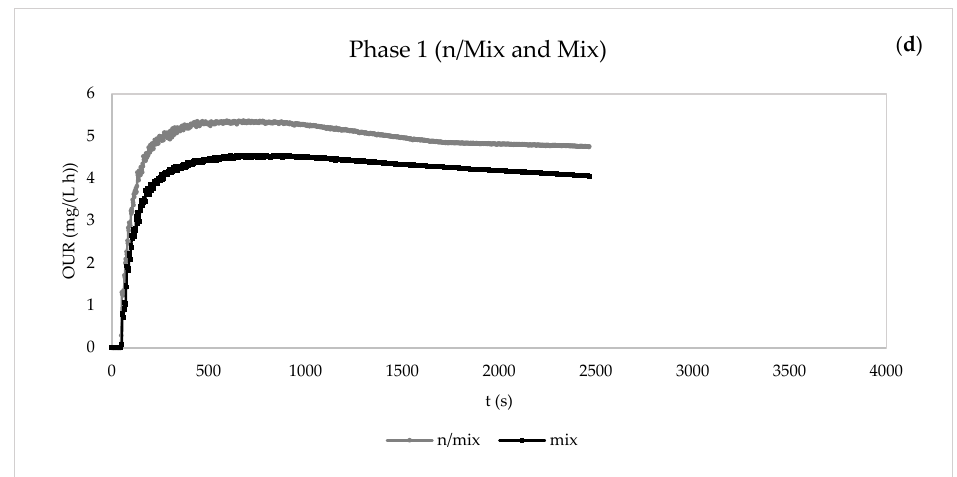
Figure 6. Evolution of static oxygen uptake rate (OUR) in the respirometric experiments in the absence and presence of pollutants for the determination of the kinetic parameters. ( a ) Phase 1: control without BPA and with BPA. ( b ) Phase 1: control without carbamazepine and with carbamazepine. ( c ) Phase 1: control without ciprofloxacin and with ciprofloxacin. ( d ) Phase 1: control without pharmaceuticals and with mixture of pharmaceuticals. n/BPA: absence of bisphenol A. BPA: presence of bisphenol A. n/CBZ: absence of carbamazepine. CBZ: presence of carbamazepine. n/CPF: Absence of ciprofloxacin. CPF: Presence of ciprofloxacin. n/Mix: absence of mix of pharmaceuticals. Mix: presence of mix of pharmaceuticals. Table 4. Kinetic parameters obtained by Equations (1)–(8) for phase one (1) and two (2) of experiments at respirometry temperature of 20 ◦ C (where Mix—the mixture of the three compounds; µ m —the maximum specific growth rate of heterotrophic biomass; K M —the half-saturation coefficient of organic matter; Y H,O2 —the yield coefficient for heterotrophic biomass referred to oxygen; b H —the decay coefficient of heterotrophic biomass; r su,H —the substrate degradation rate of organic matter removal; and r’ x,H —the net heterotrophic biomass growth